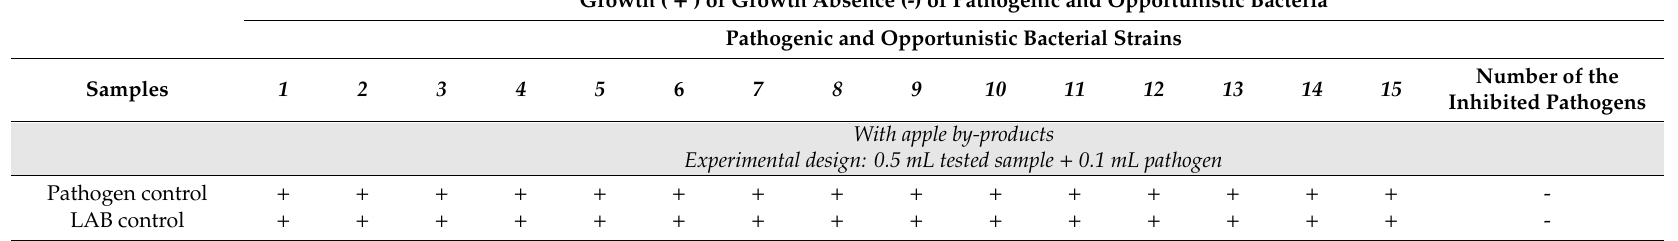
Table 3. Cont. Growth ( + ) or Growth Absence (-) of Pathogenic and Opportunistic Bacteria Pathogenic and Opportunistic Bacterial